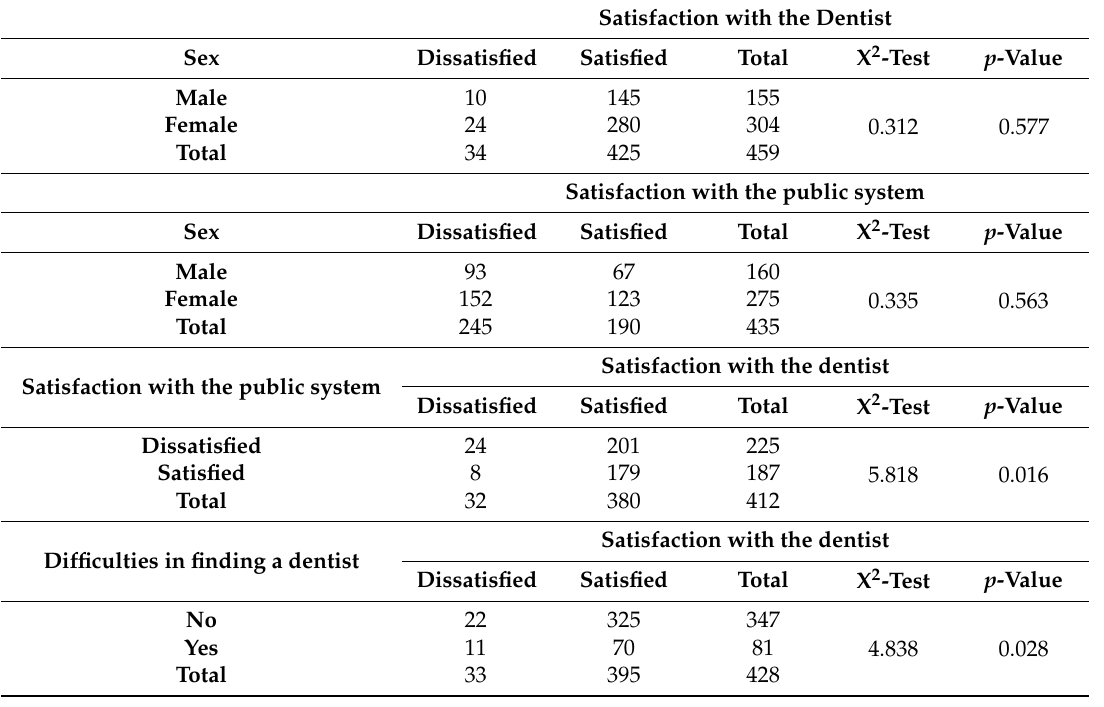
Table 2. Chi-square test.